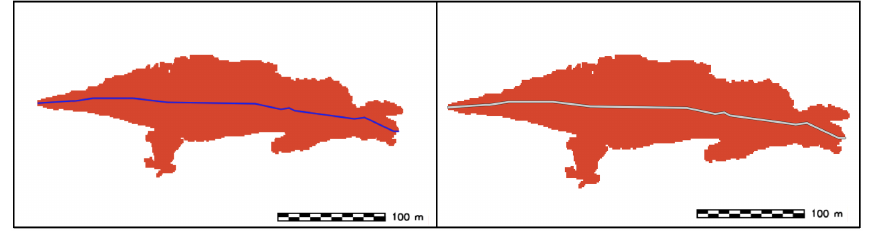
Figure 21. SWC buffering.